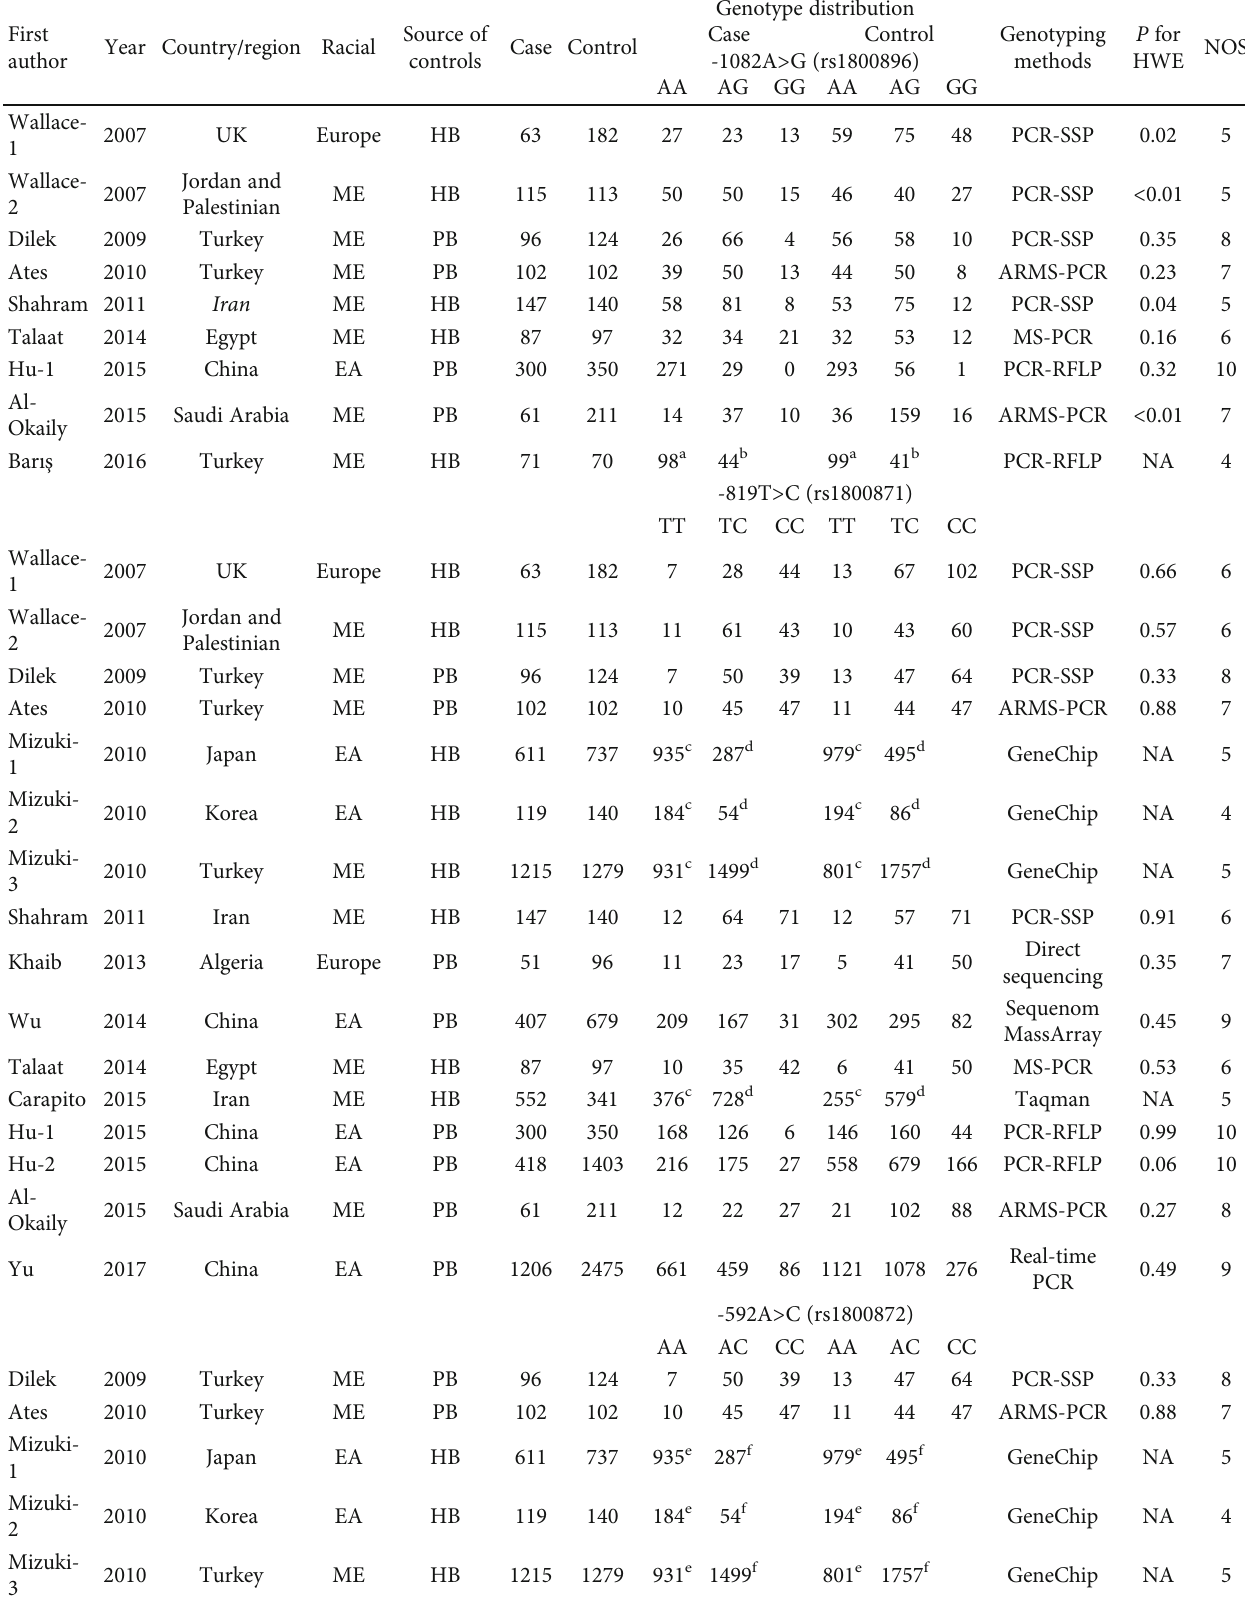
Table 2: Characteristics of included studies on IL-10 gene polymorphisms and Behcet ’ s disease